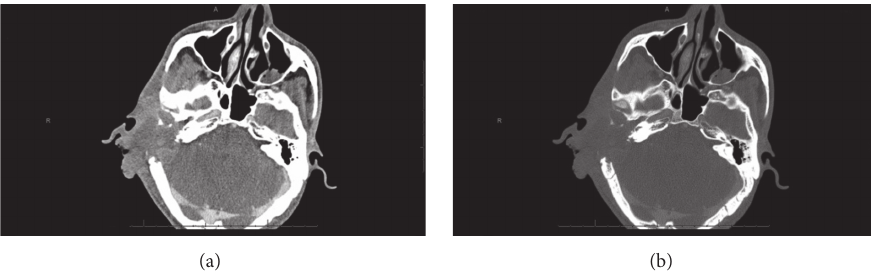
Figure 5: CT scan of the temporal bone shows that, compared to previous images, the soft tissue component was increased, causing further destruction of the middle and inner ear and a right periauricular soft tissue mass lesion with an ill-defined border.